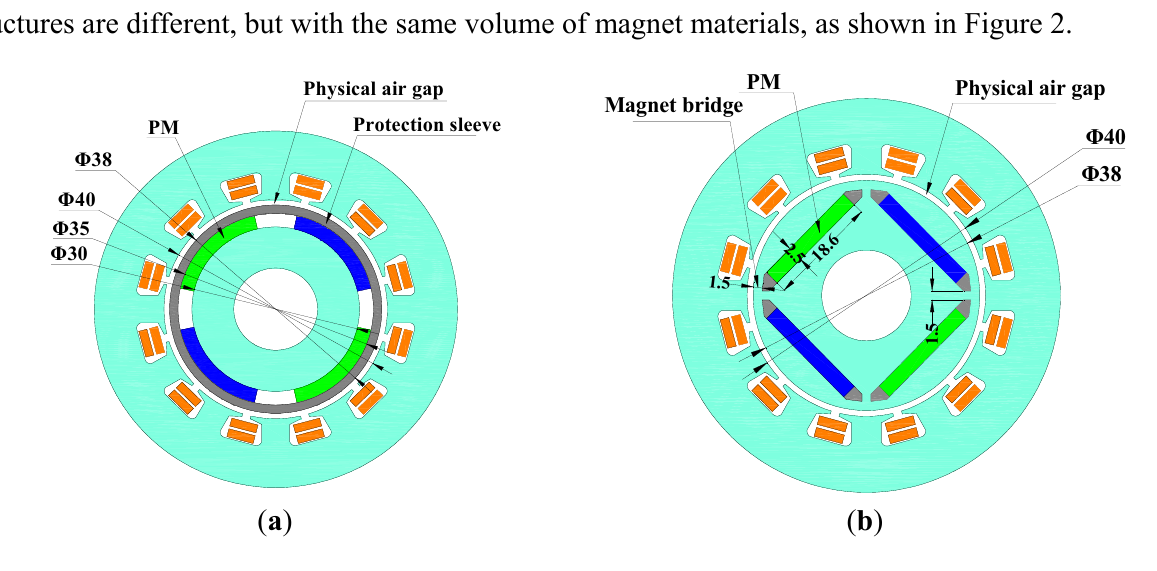
Figure 2. Dimensions of the two rotors: ( a ) SPM and ( b )